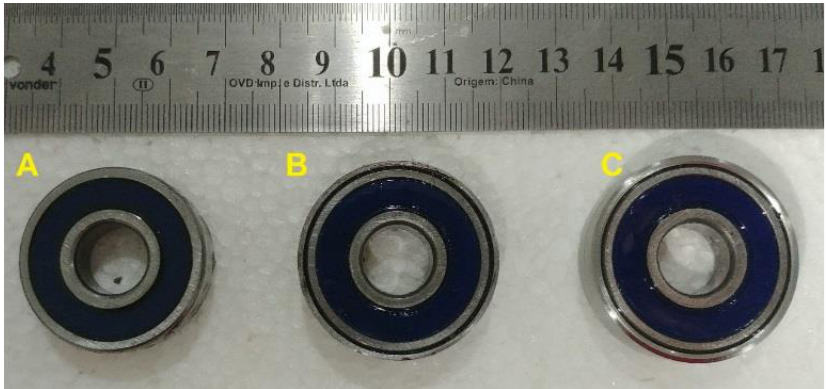
Figure 8. Steel bushing with ball bearings: ( A ) without preload; ( B ) preload of 1.0 mm; ( C ) preload of 1.5 mm.